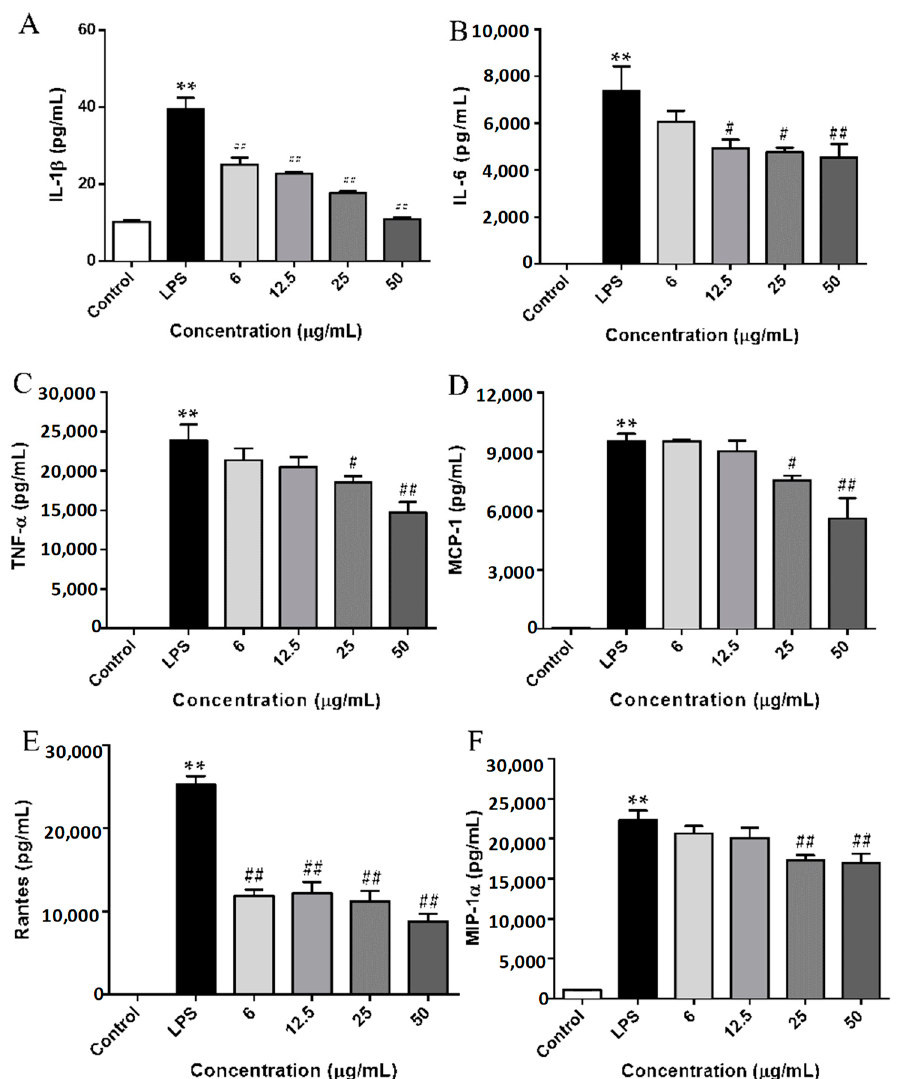
Figure 4. Effect of SCL on the production of cytokines and chemokines in LPS-stimulated RAW264.7 cells. The cells were plated in 24-wells and incubate for 12 h, and then the macrophages were pre-treated with different concentrations of SCL for 1 h and then stimulated with or without LPS (1 µ g/mL) for 24 h. IL-1 β ( A ), IL-6 ( B ), TNF- α ( C ), MCP-1 ( D ), Rantes ( E ), and MIP-1 α ( F ) concentrations in the cell culture medium were measured by ELISA. Values given are the mean ± SEM of 4 independent experiments; ** p < 0.01 vs. unstimulated cells. # p < 0.05, ## p < 0.01 vs. LPS-stimulated cells using a one-way ANOVA followed by Dunnett’s multiple comparisons test.